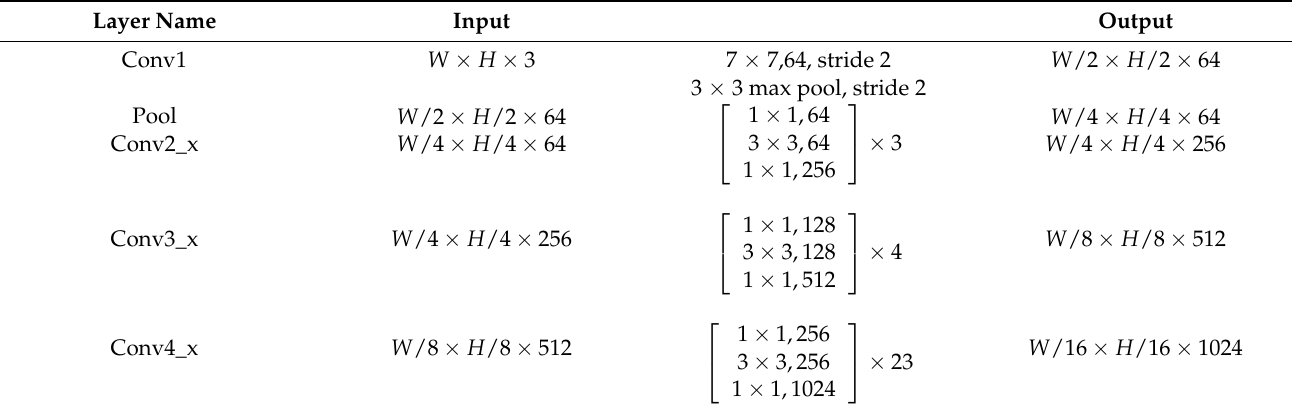
Figure 2. The complete structure of the proposed network. Table 1. The structure of the feature extraction